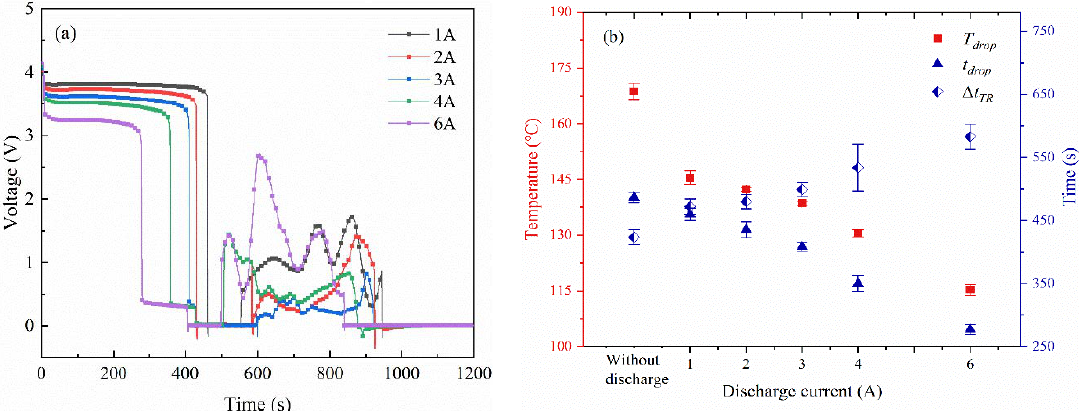
Figure 10. The voltage characteristics of the battery across thermal runaway when discharged with same C TR (Group ⅲ ). ( a ) The voltage variation. ( b ) Average values of T drop , t drop , and ∆ t TR .